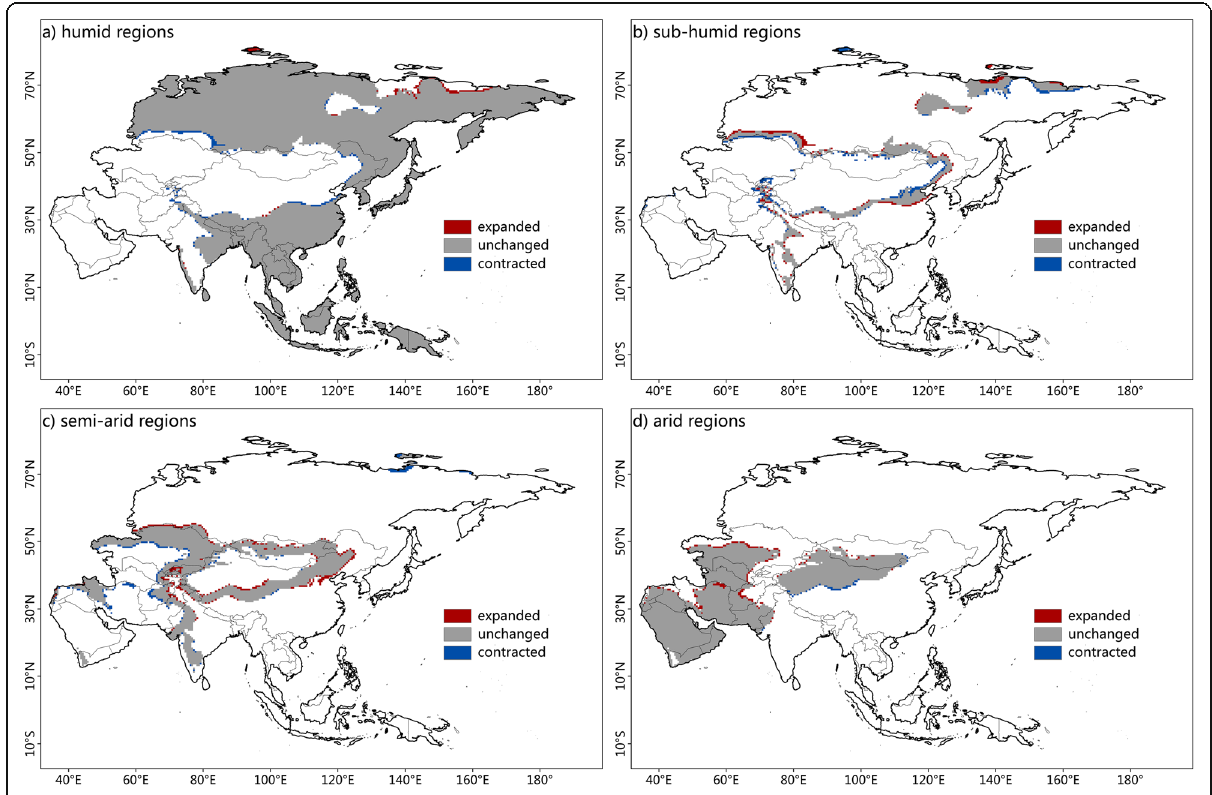
Fig. 7 Spatial distribution of humid ( a ), sub-humid ( b ), semi-arid ( c ), and arid ( d ) regions over Asia for the INDC-pledge scenario. The different colours indicate changed and unchanged areas relative to the present period. The classification of arid/humid regions are based on multi-model mean